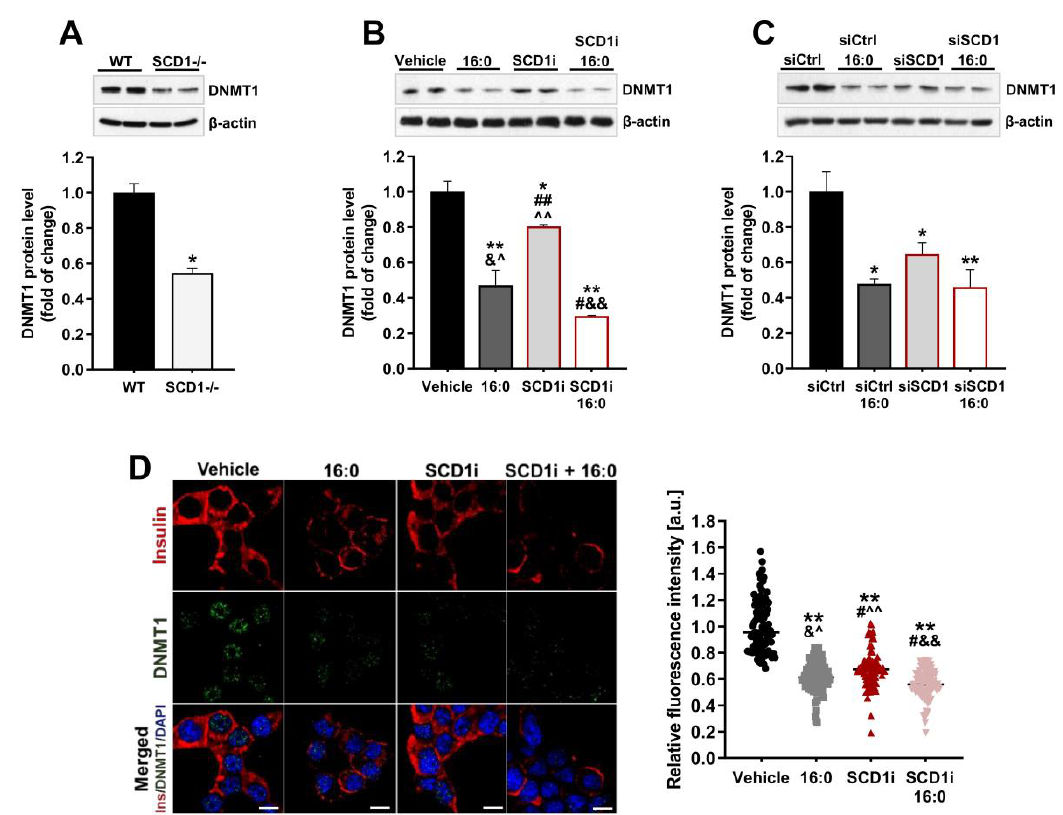
Figure 3. DNA methyltransferase 1 (DNMT1) is downregulated in SCD1-deficient pancreatic islets and INS-1E cells. ( A ) DNMT1 protein levels in SCD1 − / − pancreatic islets and WT islets. n = 6. * p < 0.05, vs. WT. ( B , C ) Western blot analysis of DNMT1 protein levels in INS-1E cells after SCD1 inhibition with A939572 (SCD1i) ( B ) or silencing of SCD1 gene expression by siRNA (siSCD1) ( C ) and palmitate (16:0) treatment. ( D ) Immunofluorescence staining of DNMT1 and quantitative analysis of DNMT1 content in nuclei in INS-1E cells that were treated with the SCD1 inhibitor. The data are expressed as mean ± SD. Scale bar = 10 µ m. * p < 0.05, ** p < 0.005, vs. vehicle / siCtrl; # p < 0.05, ## p < 0.005, vs. 16:0; & p < 0.05, && p < 0.005, vs. siSCD1i; ˆ p < 0.05, ˆˆ p < 0.005, vs. SCD1i +